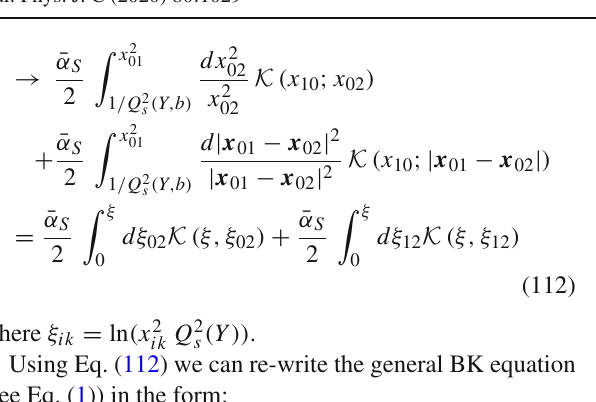
scattering amplitude deep in the saturation region. In Fig.